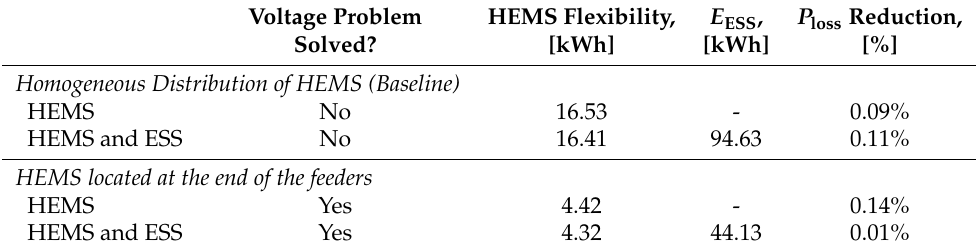
Table 5. Results the location of HEMS scenario considering only “HEMS” and “HEMS and ESS”. Voltage Problem HEMS Flexibility, E ESS , P loss Reduction, Solved? [kWh] [kWh] [%] Homogeneous Distribution of HEMS (Baseline) HEMS No 16.53 - 0.09% HEMS and ESS No 16.41 94.63 0.11% 4.42 - 0.14% 44.13